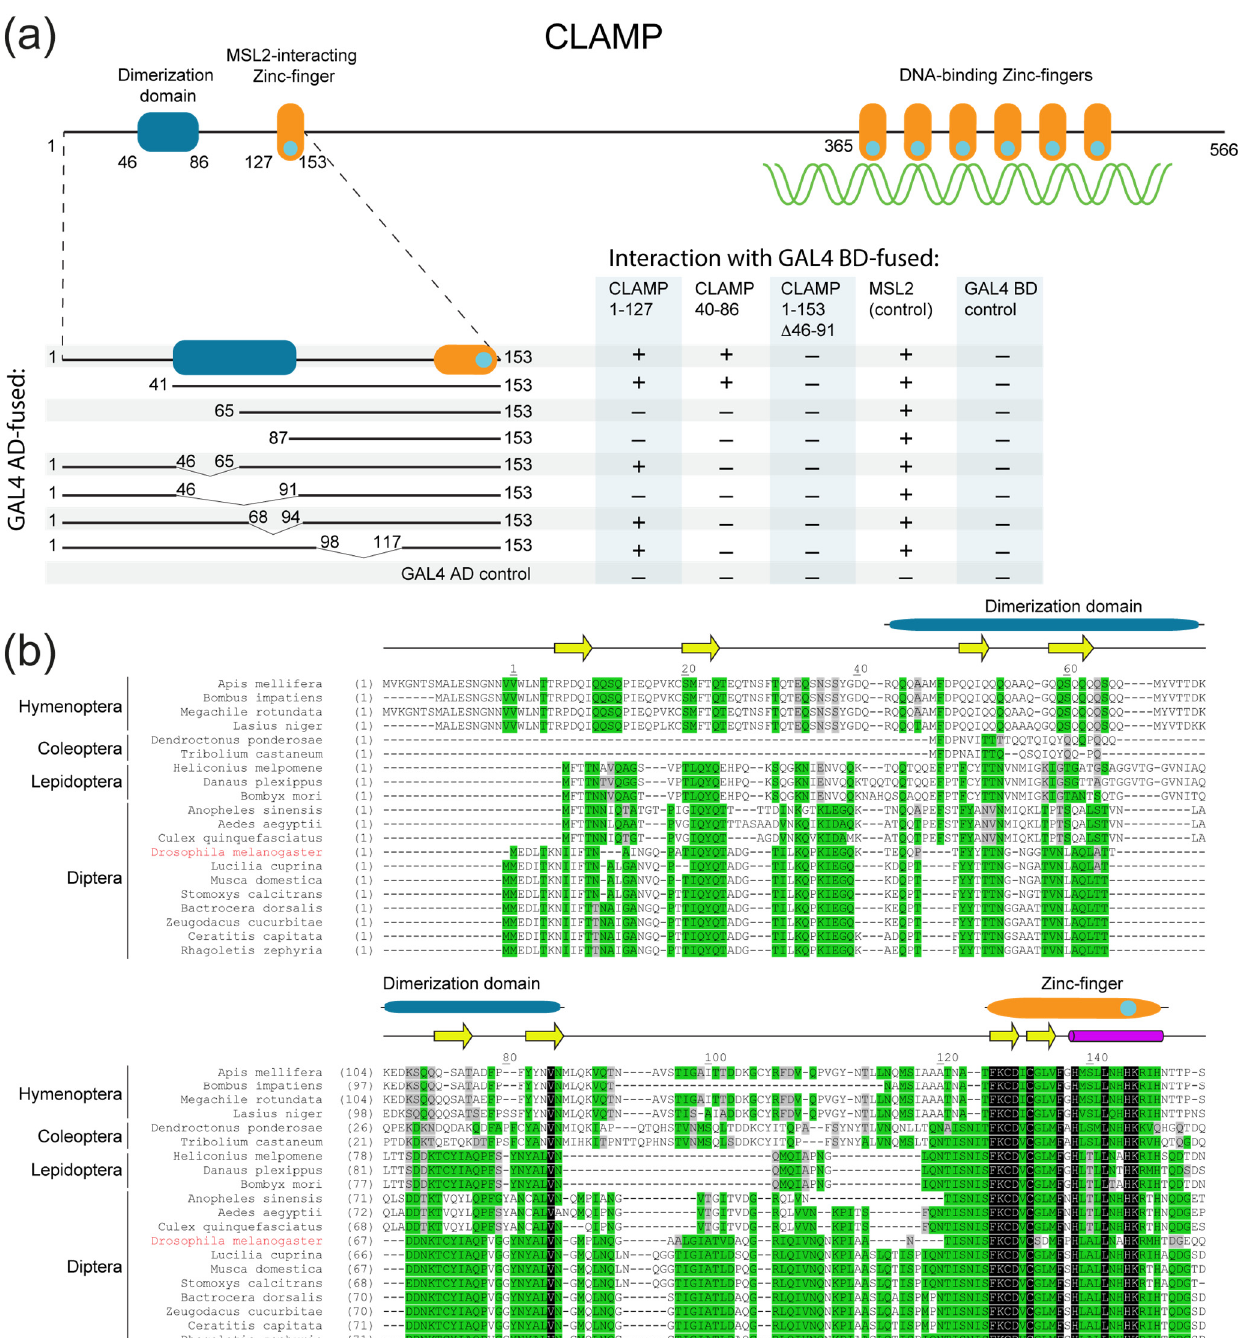
Figure 1. ( a ) Results of the Y2H assay of dimerization activity of the CLAMP N-terminal region shown for the domain structure of the CLAMP protein. AD stands for GAL4 activation domain and BD stands for GAL4 DNA-binding domain. Positive interaction indicates the ability of yeast to grow on assay plates without histidine. Assay plates are shown in Figure S2. ( b ) Multiple sequence alignment of N-terminal domains of CLAMP proteins from various insects performed with ClustalW [47]. The positions of predicted secondary structure, dimerization, and zinc-finger domains are shown. Residue numbering corresponds to D. melanogaster CLAMP.